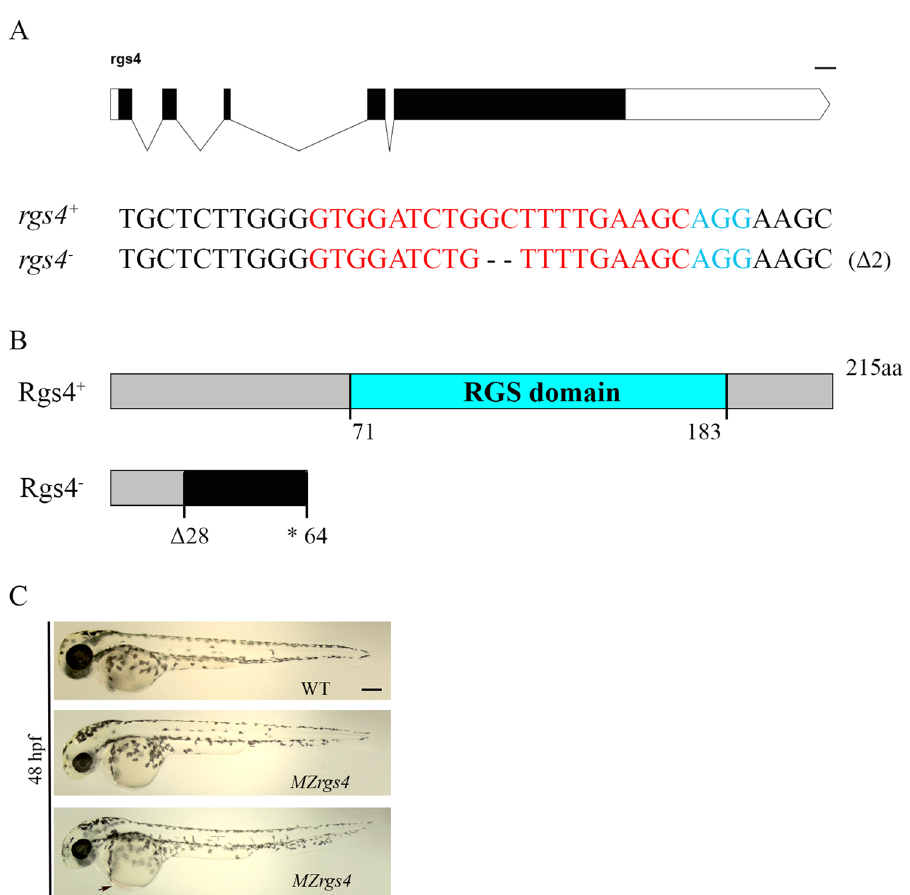
Figure 1. Characterization of rgs4 mutant. ( A ) Schematic representation of the rgs4 genomic locus. The extended region on the exon 2 represents the sequence targeted by the CRISPR/Cas9 system. Red: sgRNA binding site. Blue: PAM sequence. Rgs4 + corresponds to the wild-type allele; rgs4 − is the loss-of-function allele used in this study. Dashes represent the 2 base pairs deletion. ( B ) Schematic of the wild type Rgs4 protein (Rgs4 + ) and the mutated Rgs4 protein (Rgs4 − ). The 215 amino acid (aa) long Rgs4 + protein contains the RGS domain from amino acid 71 to 183. In rgs4 −/− mutant fish, the 2 base pairs deletion results in a frame shift from the amino acid 28 generating a premature STOP codon at the level of the amino acid 64. ( C ) Lateral views of WT and MZrgs4 embryos at 48 hpf; black arrow designates a slight heart oedema observed in MZrgs4 embryos. Scale bar = 200